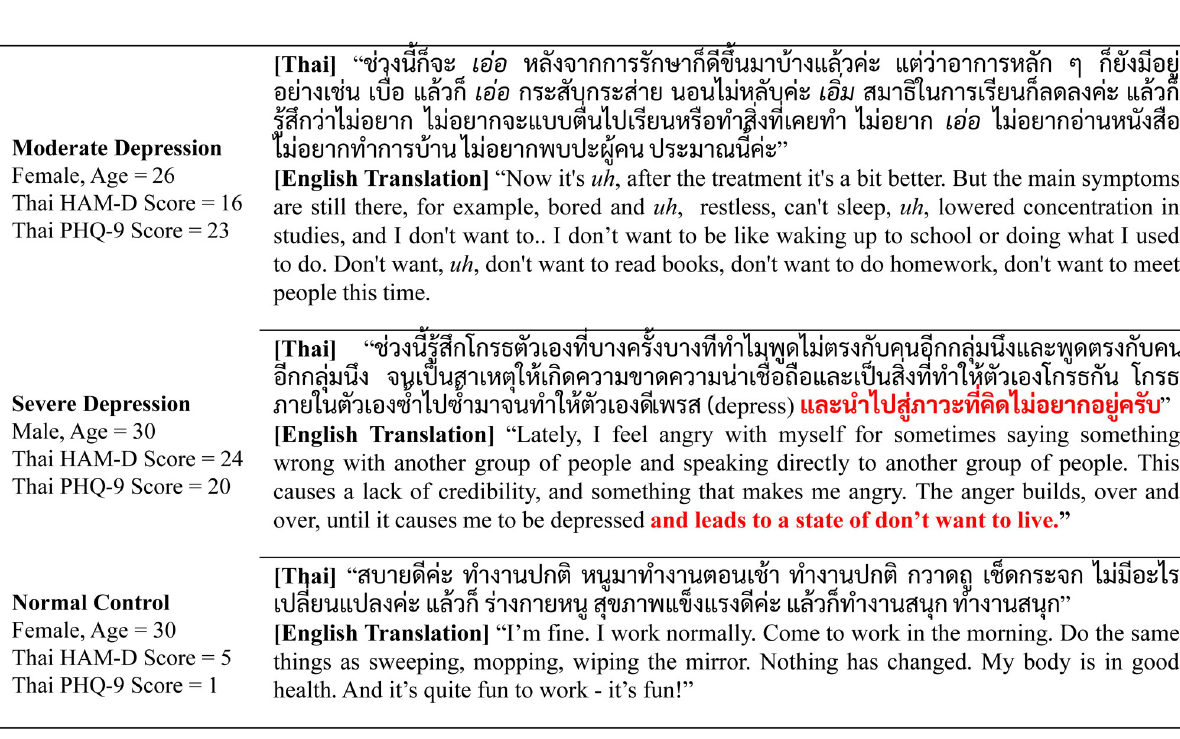
Fig 2. Samples of transcription of speech response from participants with original language (Thai) and English